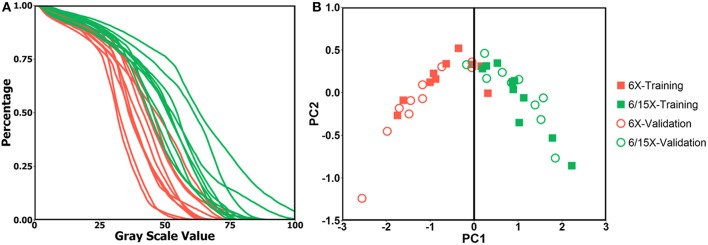
(A) DRR intensity histogram for single energy cases (red) and mixed energy cases (green); (B) PC1 and PC2 score of single energy cases (red) and mixed energy cases (green) for training dataset (solid square) and validation dataset (circle), PC1 = 0 is shown as black line.